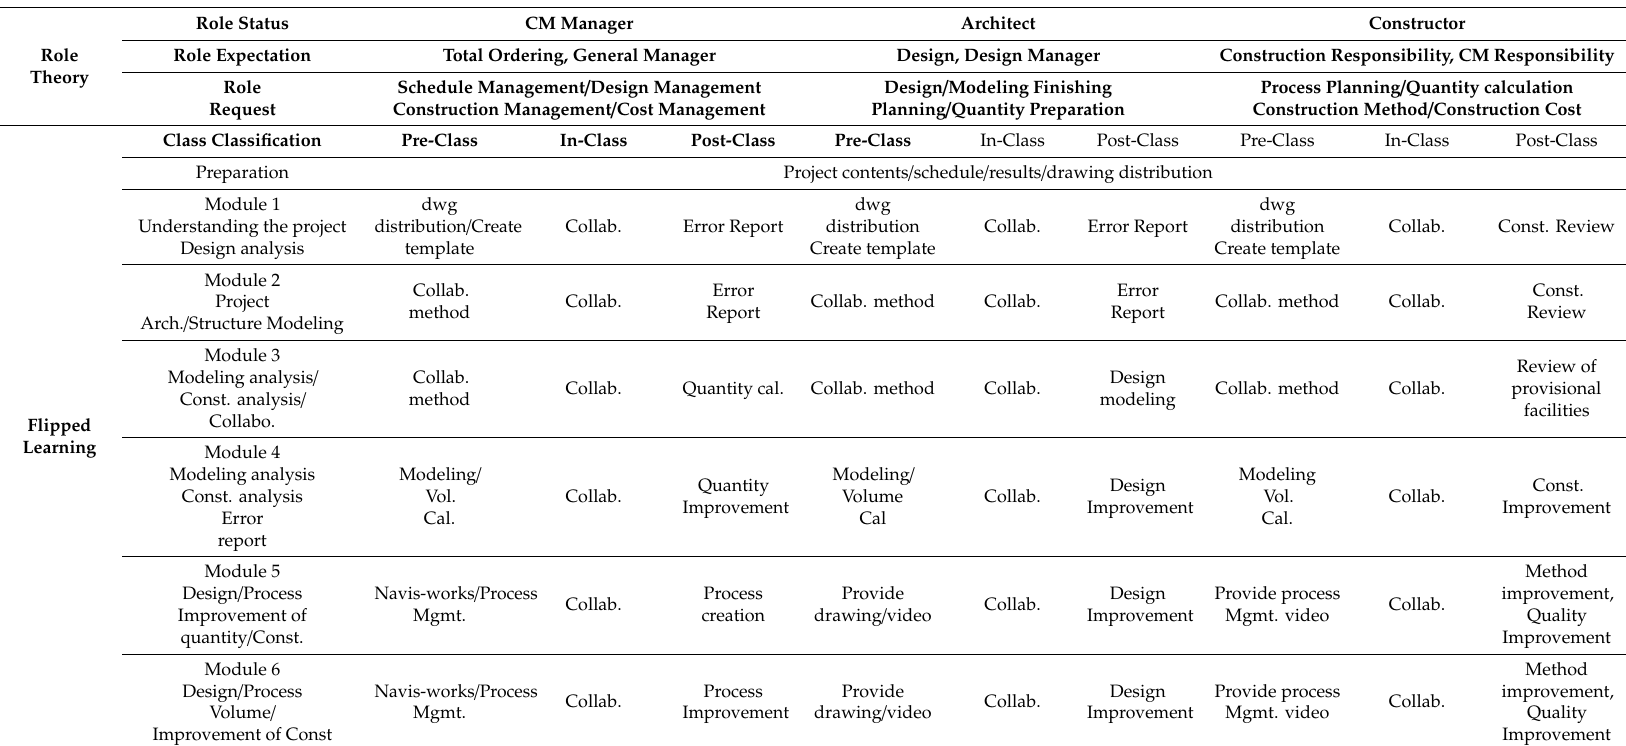
Table 6. Constructivism collaboration process training